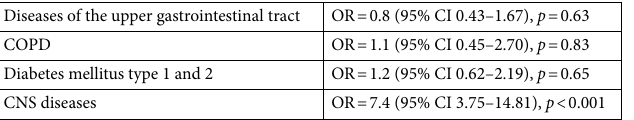
Table 2. Association of OD with concomitant